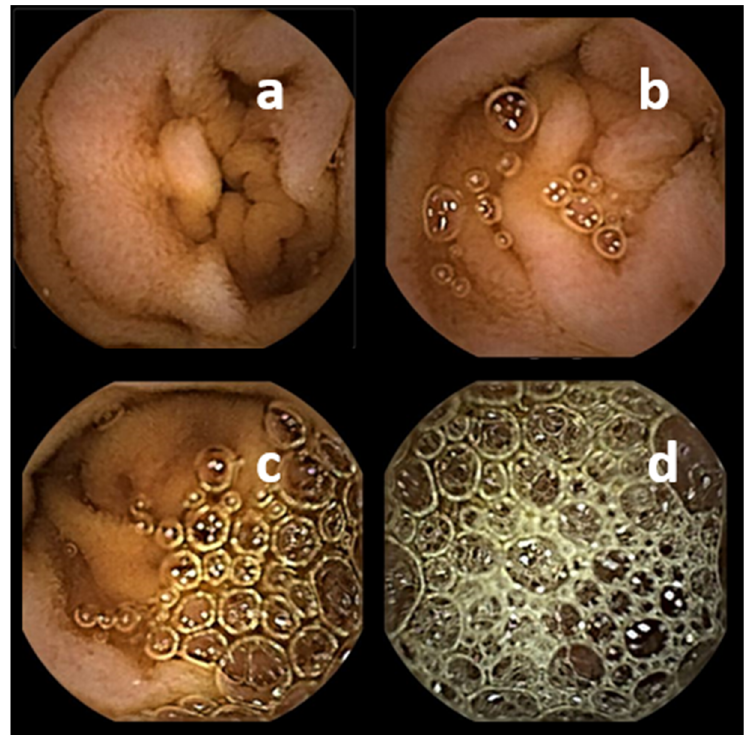
Figure 1. SBCE: Abundance of air bubbles: ( a ) none, ( b ) minimal, ( c ) mild, ( d ) severe.